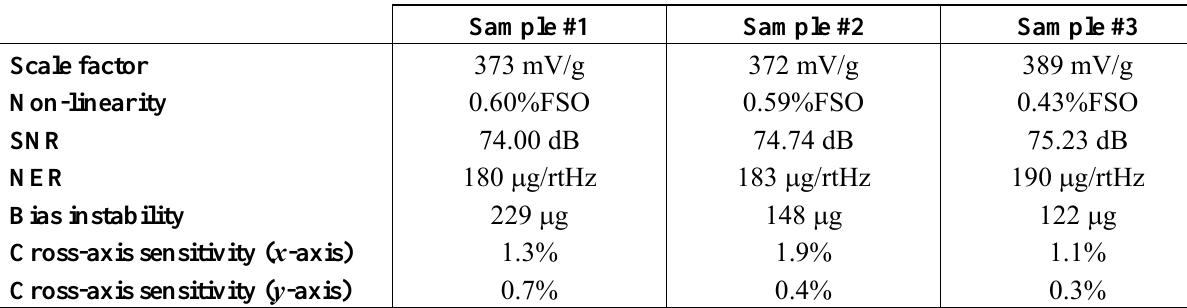
Table 2. Summarized performance